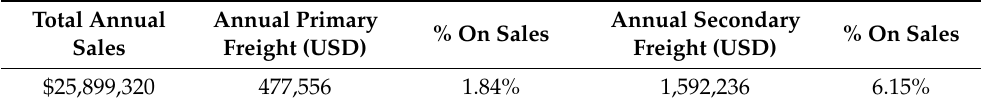
Table 5. Consolidated annual freight.